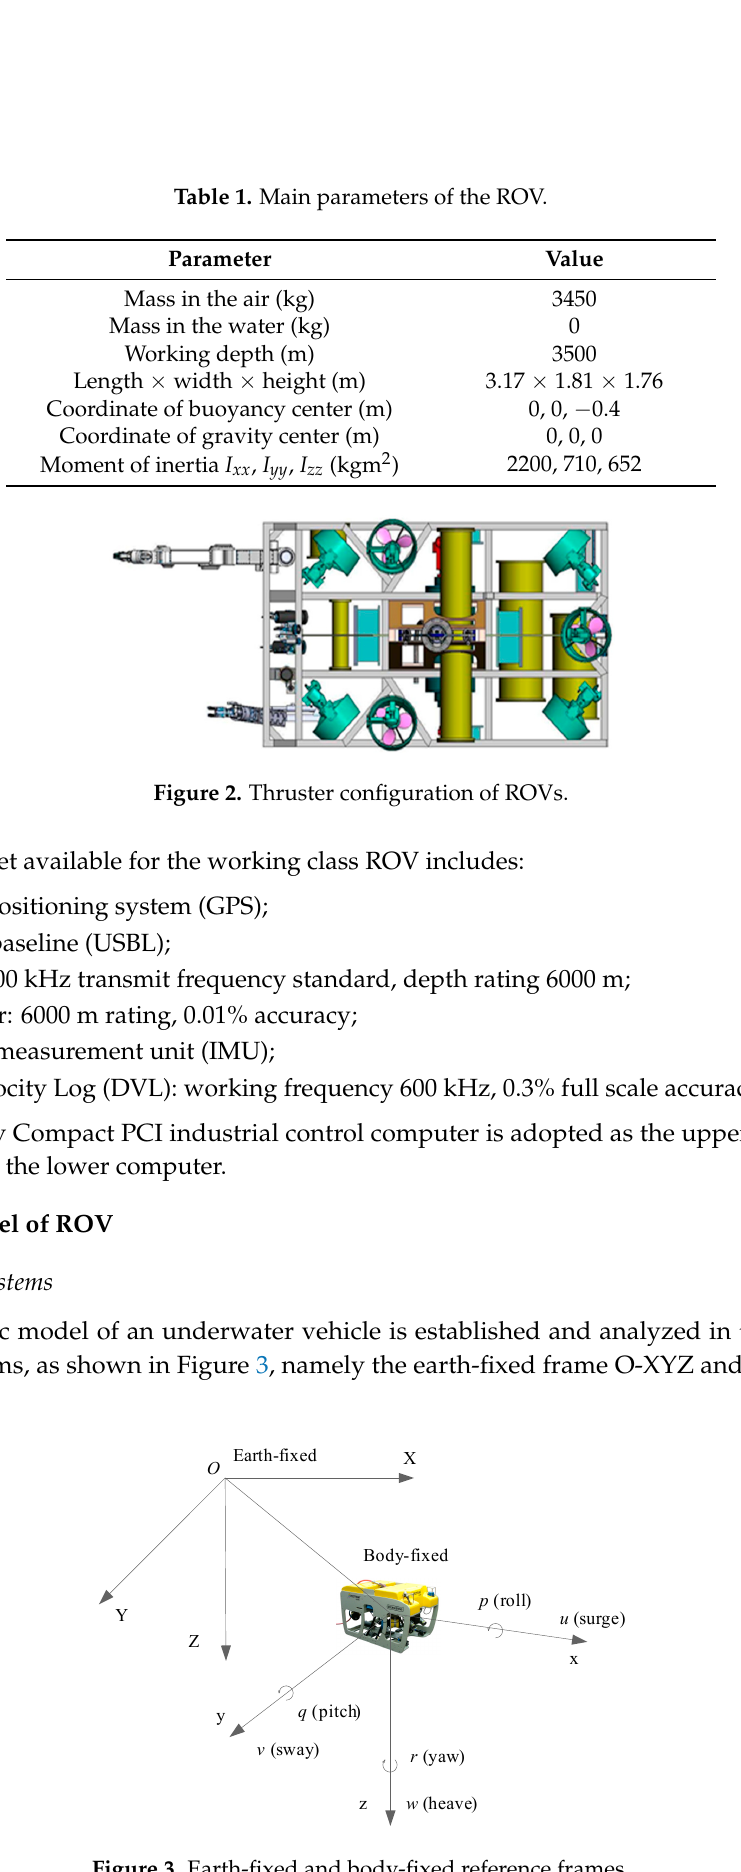
Figure 3. Earth-fixed and body-fixed reference frames.